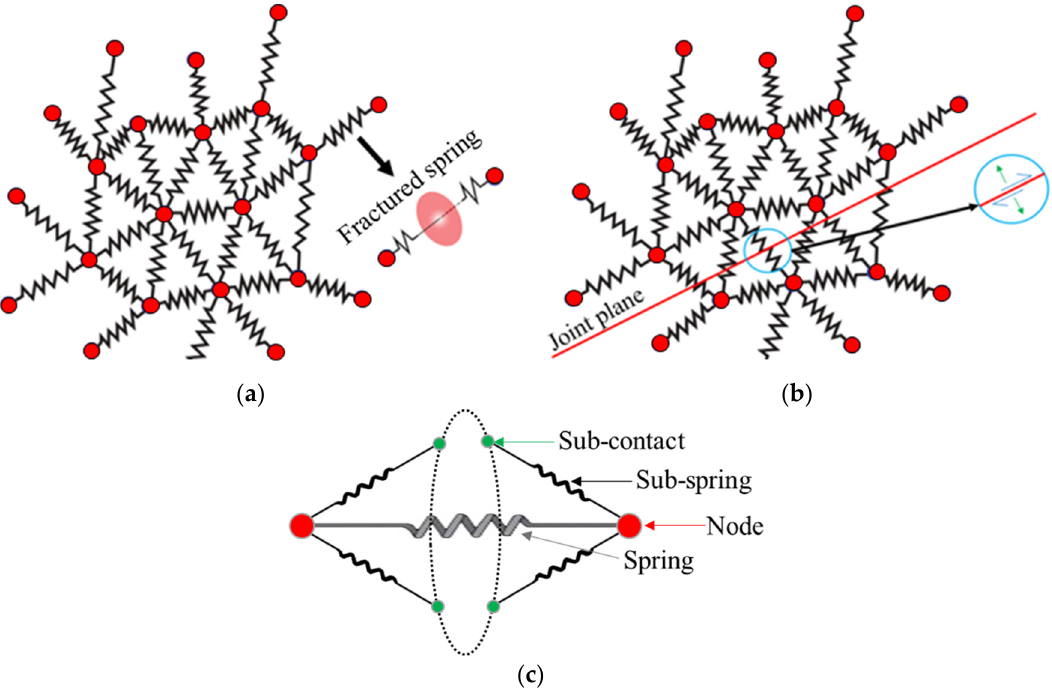
Figure 2. ( a ) Fractured lattice replaced broken spring, ( b ) discontinuity plane superimposed in the lattice springs, ( c ) Flat joint contact logic (modified after [28]).